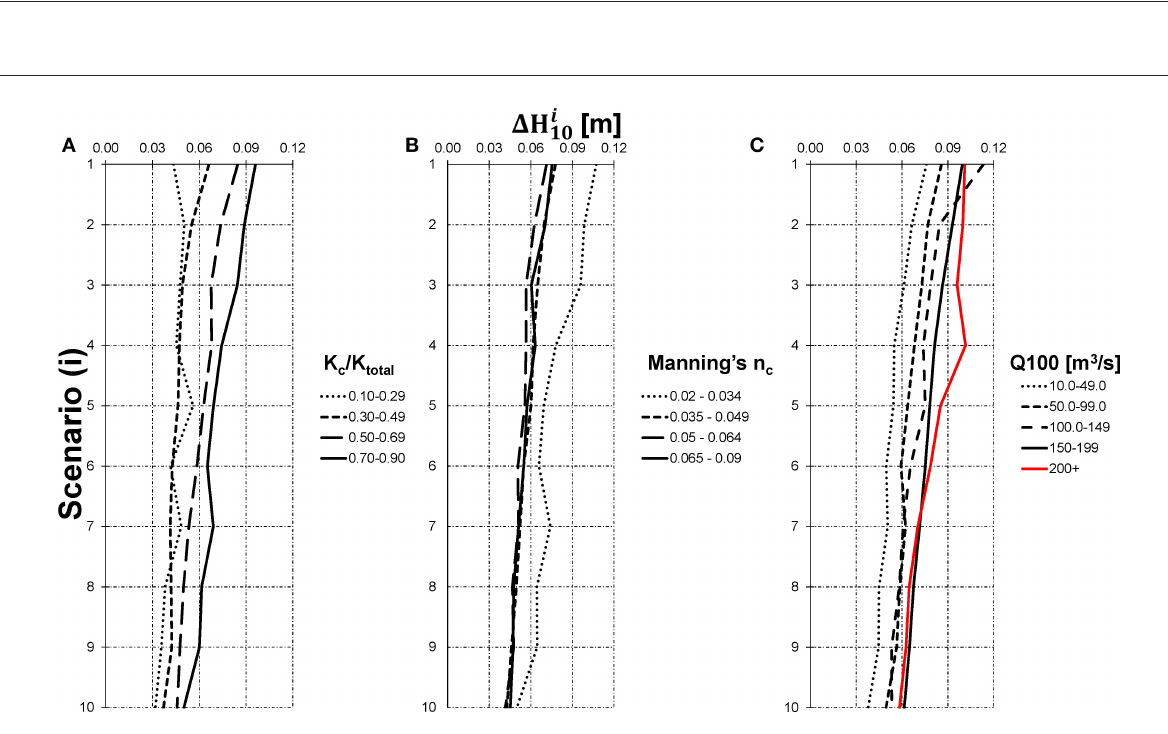
FIGURE4 Peak flood height absolute incremental sensitivity grouped by (A) k -index, (B) main channel resistance, (C) 100-year peak discharge for scenarios 1,